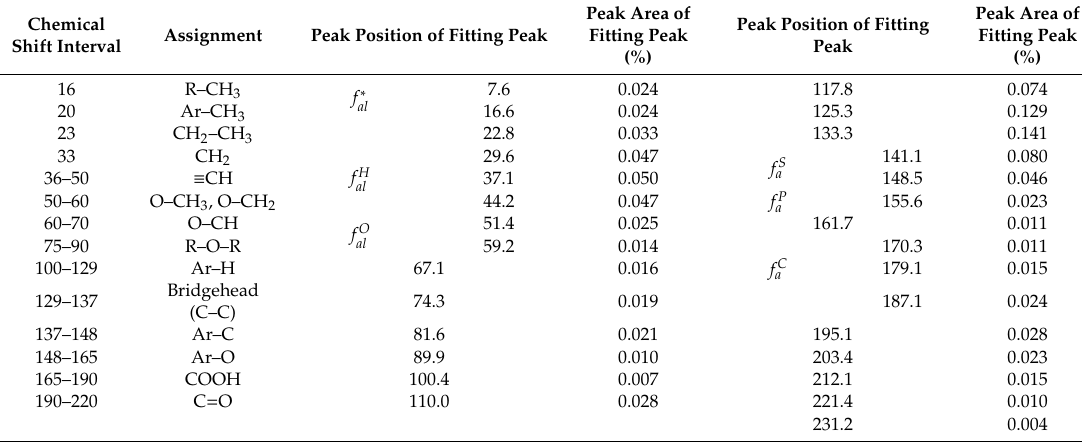
Figure 8. 13 C-CP / MAS NMR spectrum of the demineralized HNC. In the figure, the red solid line is the fitting curve, the black circle is the original data point, and the dotted line is the baseline. Table 4. Assignment of the chemical shift interval and fitting peak parameters (including the calculation of the main structural parameters) in the 13 C-CP / MAS NMR